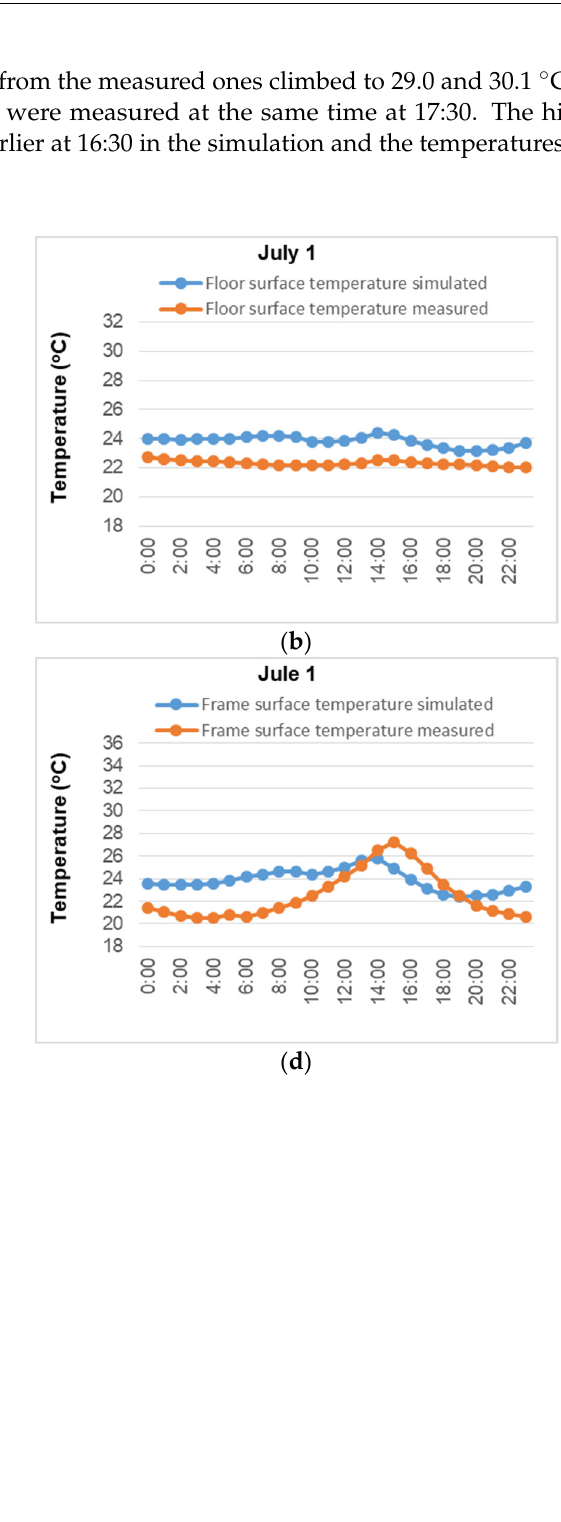
Figure 12. Comparison of all-day courses of indoor air and surface temperatures: ( a ) indoor air tem- perature, ( b ) floor surface temperatures, ( c ) surface temperatures on glazing, ( d ) surface temperatures on the window frame, and ( e ) surface temperatures on the ceiling.